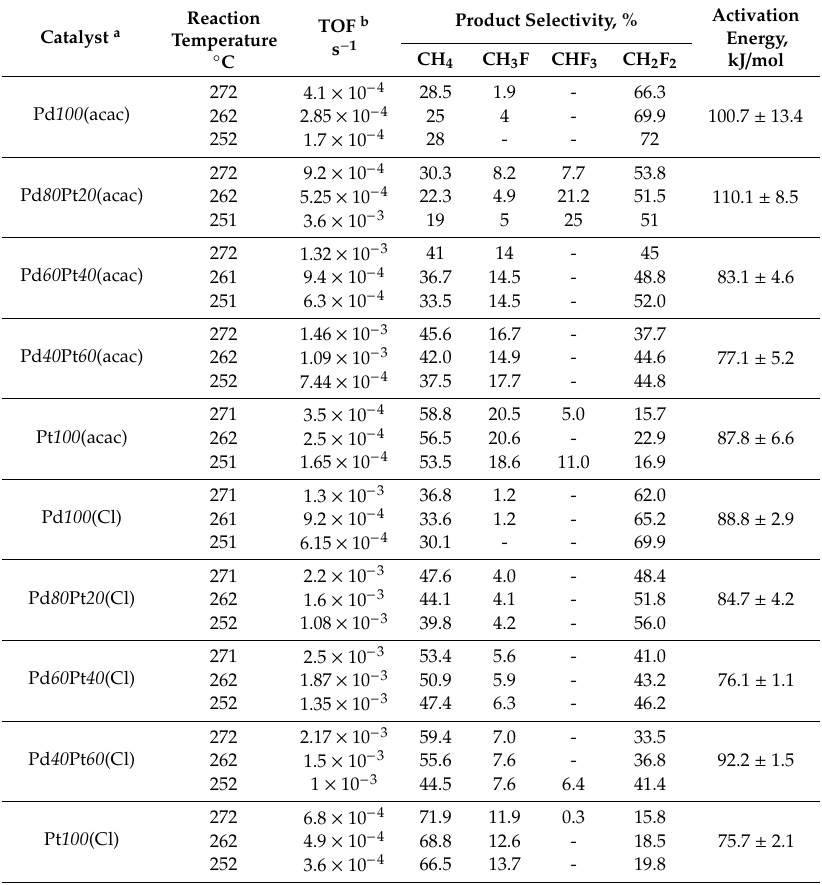
Table 3. CHClF 2 hydrodechlorination on two series of Pd–Pt / C catalysts. Turnover frequencies, product selectivities, and activation energies.